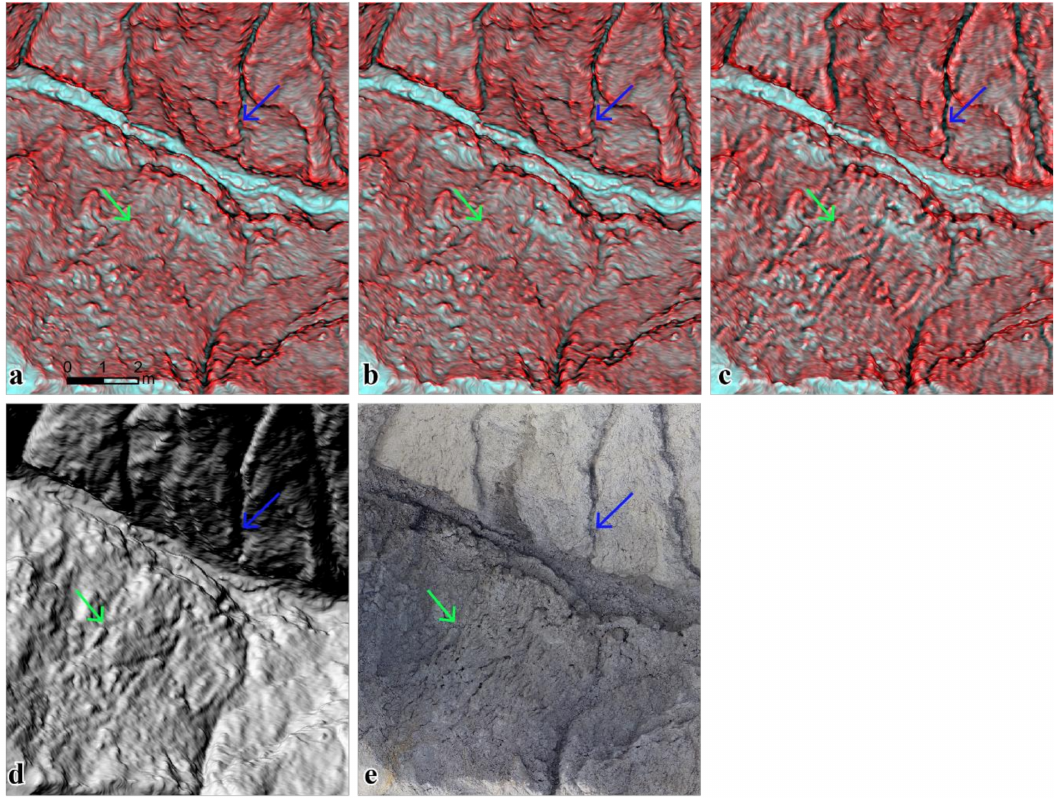
Figure 10. ( a ) Comparison of the 2P relief maps with slope–openness, ( b ) with slope–total curvature, ( c ) with slope–plan curvature, ( d ) hillshade map, and ( e ) ortho-image (popcorn-like morphology: green arrow and rill: blue